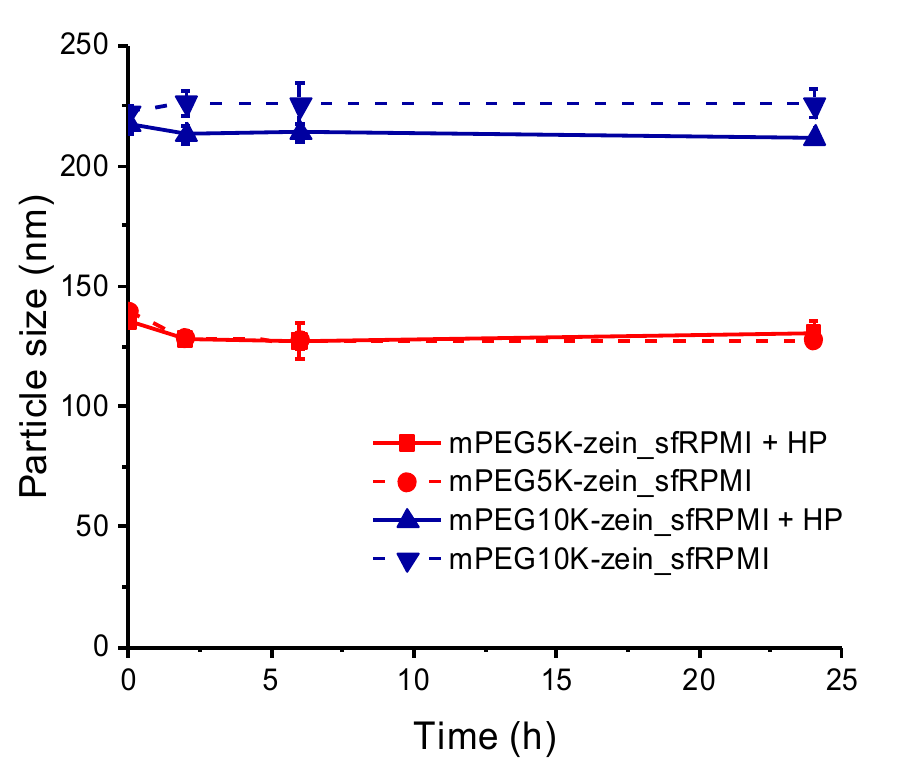
Figure 4. Size of mPEG5K-zein and mPEG10K-zein micelles in the presence or absence of human plasma (HP) (“sfRPMI”: serum-free RPMI medium, “sfRPMI + HP”: serum-free RPMI medium + 10% ( v / v ) HP) ( n = 3).